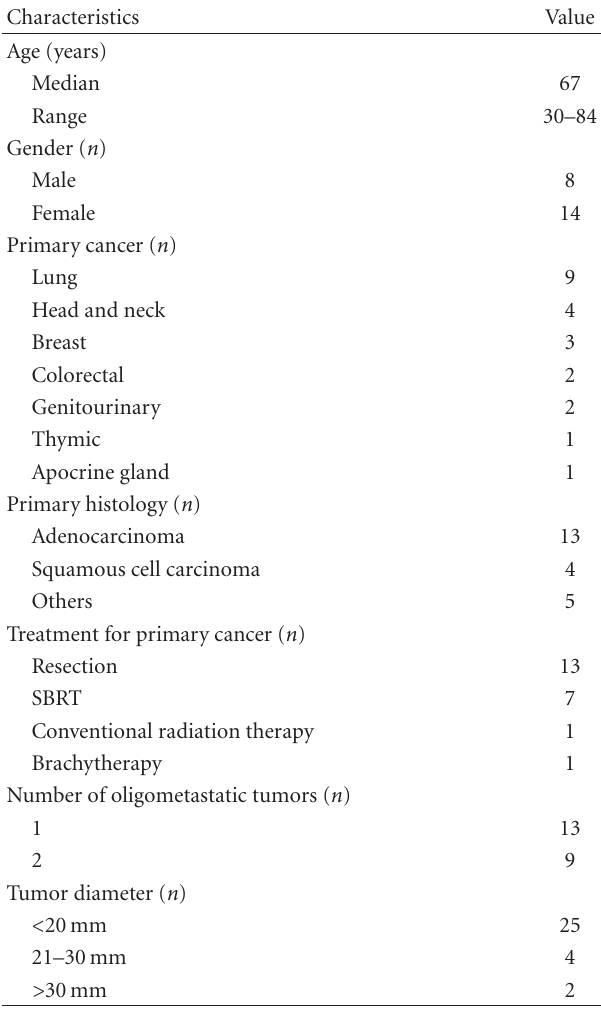
Table 1: Patient characteristics (22